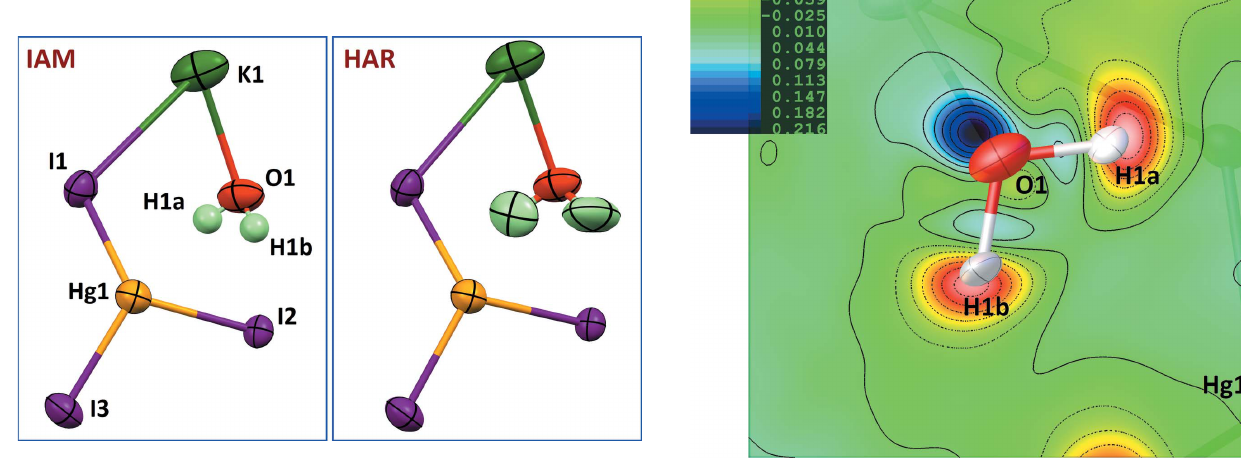
Figure 2 Ellipsoid plots of the asymmetric unit for the IAM (left) and HAR (right) models, with displacement ellipsoids at the 85% probability level. For the IAM refinement, isotropic H atoms are shown as spheres of arbitrary radius, while anisotropic H atoms in the HAR panel are shown with their refined ADPs.